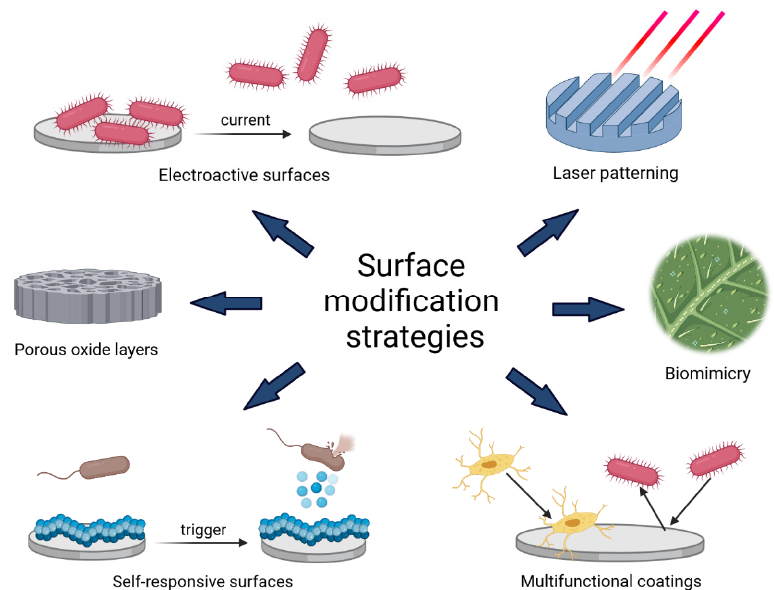
Figure 6. Schematic representation of surface modification strategies allowing the control of biofilm growth on the surface of implants, namely electroactive surfaces, surfaces engineered by laser treatment, biomimetic anti ‐ adhesion coatings, multifunctional antibacterial coatings, switchable and self ‐ responsive antibacterial coatings, and antibacterial/anti ‐ adhesive porous oxide layers.